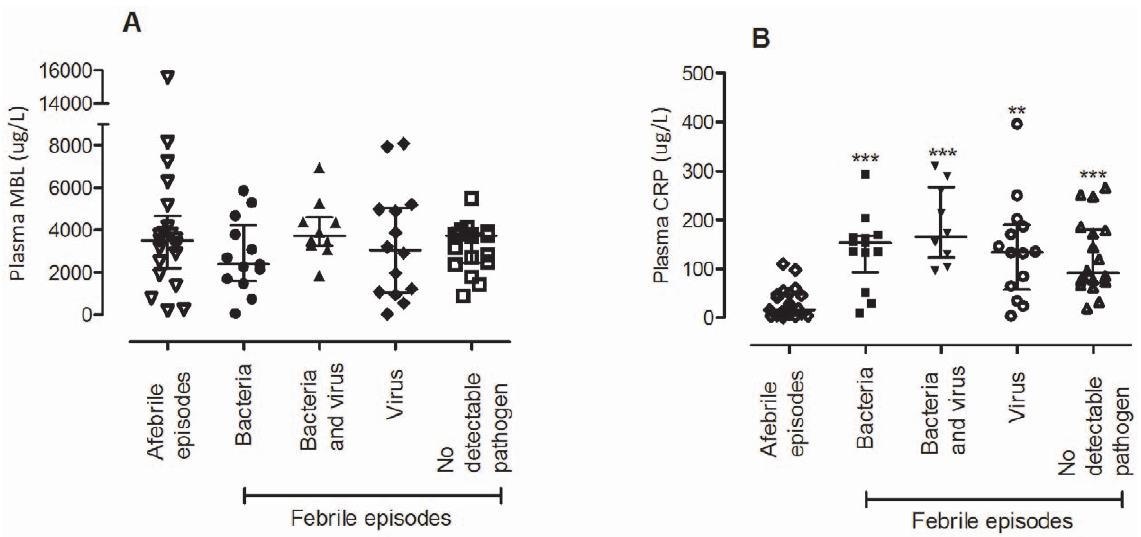
Figure 2. Plasma concentrations of (A) MBL and (B) CRP, in afebrile and febrile episodes based on pathogen detected. Comparisons were made between afebrile episodes and febrile episodes with further catergorisation based on microbiological findings. Numbers in the respective groups are listed in Table 2 (** p , 0.01, *** p , 0.001).